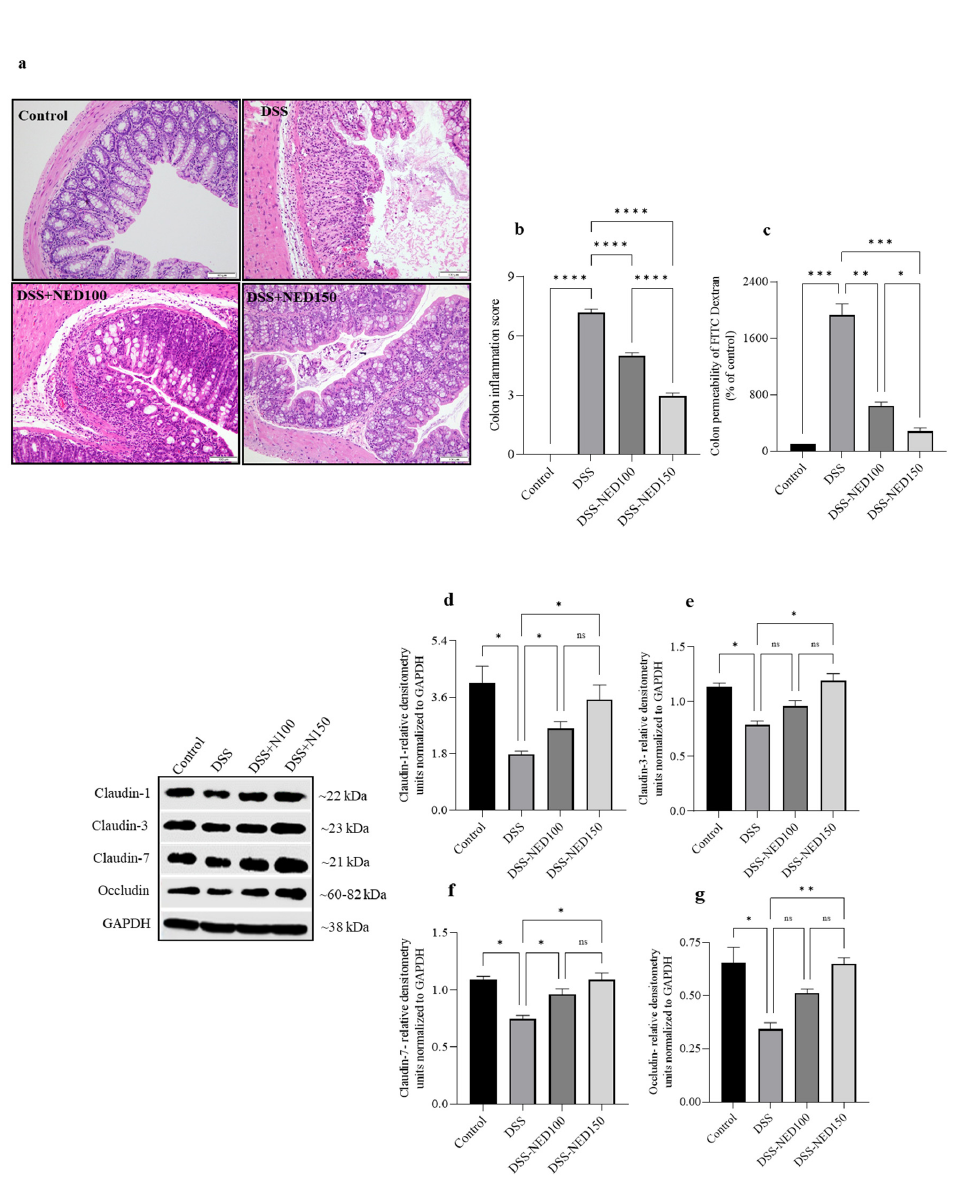
Figure 5. Effect of NED on colon histology, colon permeability, and colon epithelial tight junction protein expression in DSS-induced colitis mice. DSS administration significantly altered colon microarchitecture with an increase in colon inflammation score, and NED prevented it ( a , b ). DSS administration signi fi cantly enhanced FITC-dextran permeability ( c ). NED treatment at 100 and 150 mg/kg doses signi fi cantly inhibited the DSS-induced increased permeability of FITC-dextran. ( d – g ) DSS signi fi cantly downregulated claudin-1, -3, -7, and occludin protein expression. NED treatment signi fi cantly increased tight junction protein expression. Data expressed as mean ± SEM (n = 6). * p ≤ 0.05, ** p ≤ 0.01, *** p ≤ 0.001, **** p ≤ 0.0001, and ns indicates not signi fi cant.